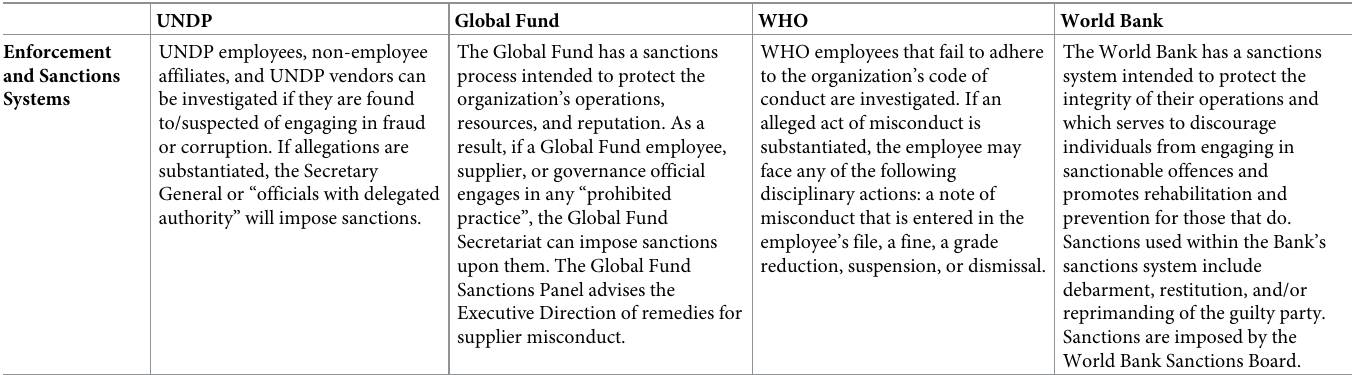
Table 6. Enforcements and